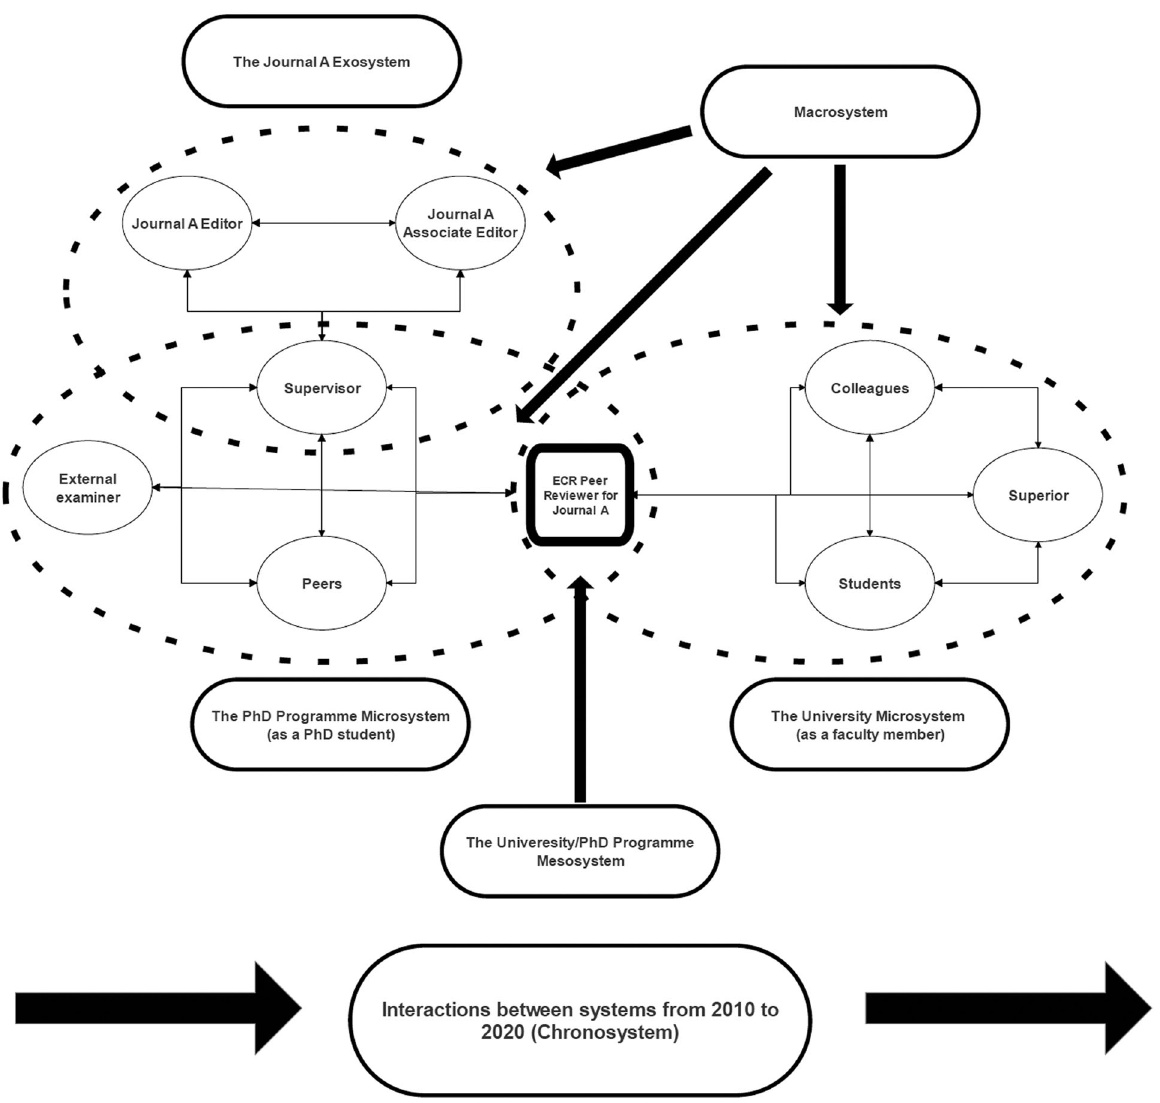
Fig. 2 A hypothetical example of a networked theory of ecological systems. This is a hypothetical example of an early career researcher who is involved in scholarly peer review for Journal